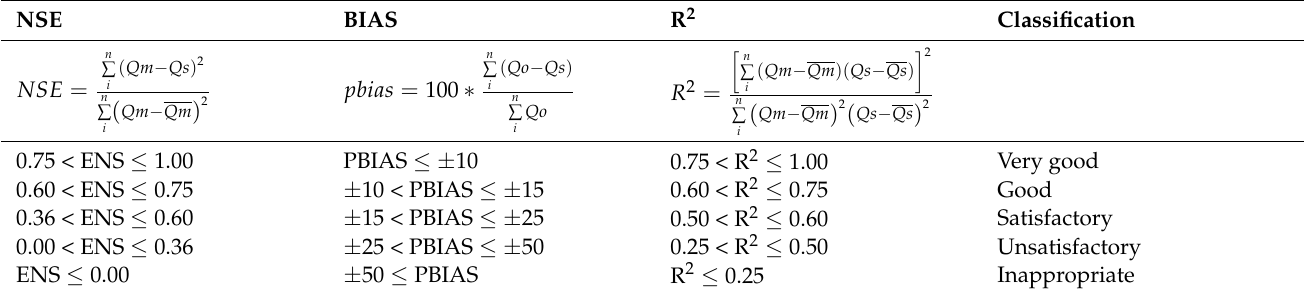
Table 2. Classification of statistical model performance